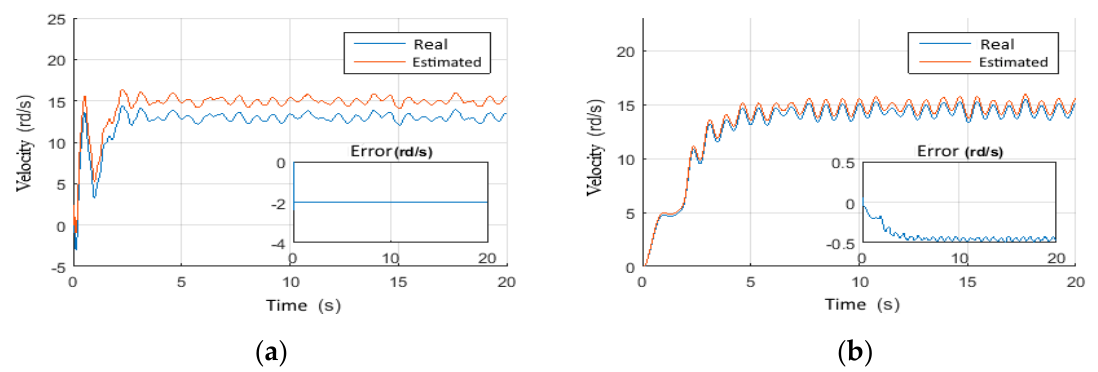
Figure 42. Real and estimated Top drive velocity under: ( a ) LQG controller, ( b ) H ∞ controller.